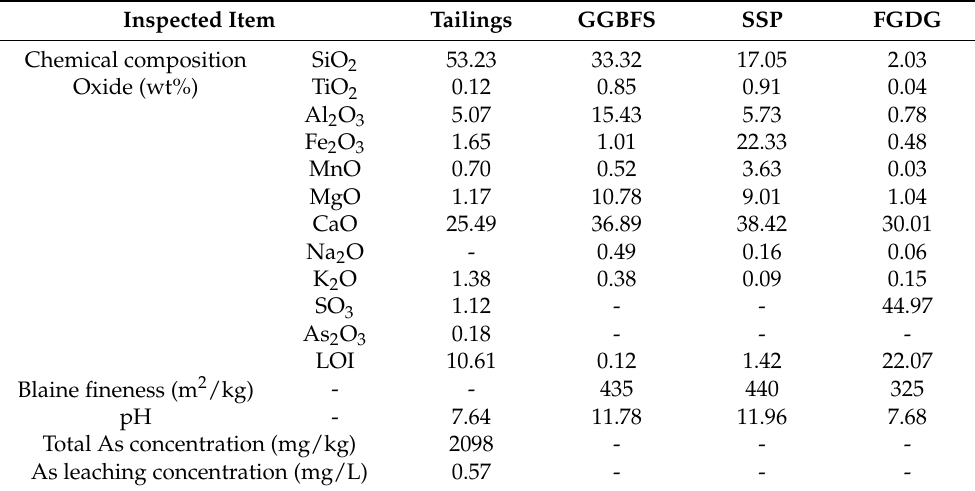
Table 1. Raw material chemical components, blaine fineness, component concentrations and leaching concentration of As. Inspected